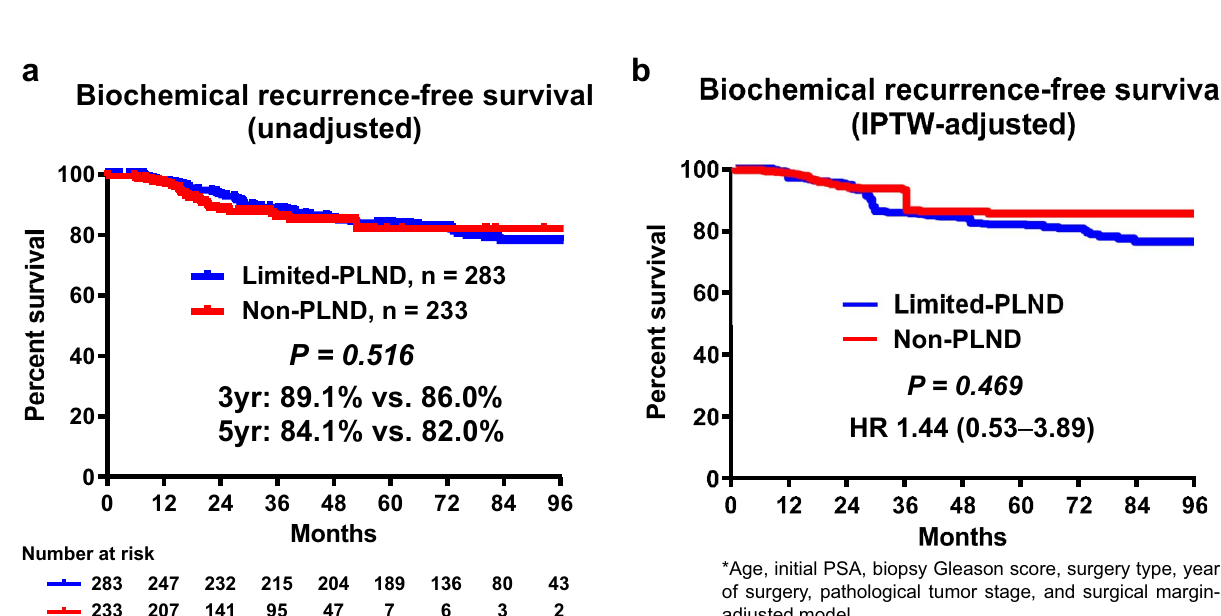
Figure 3. Unadjusted ( a ) and IPTW-adjusted biochemical recurrence-free survival ( b ), between the limited- PLND and non-PLND groups. IPTW inverse probability of treatment weighting, PLND pelvic lymph node dissection, PSA prostate-specific